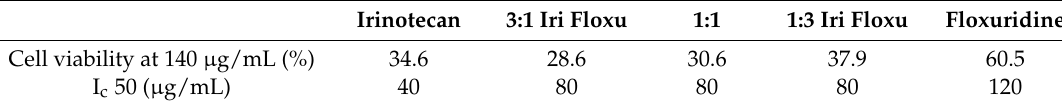
Table 1. Comparison of the different MIL88A loadings and their IC 50